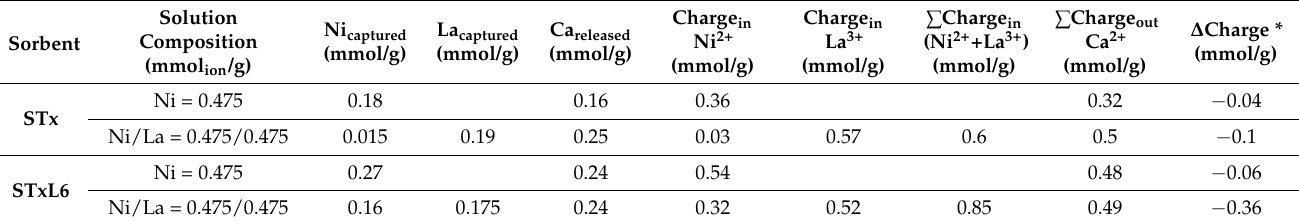
Table 3. Charge balance calculation upon capture step for mono-ionic and bi-ionic solutions in presence of STx and STxL6 sorbent solids. (* ∆ Charge = ∑ Charge out − ∑ Charge in ) where Charge in and Charge out include the different ionic species. (Average of three measurements, error estimated from the replicate measurements is within